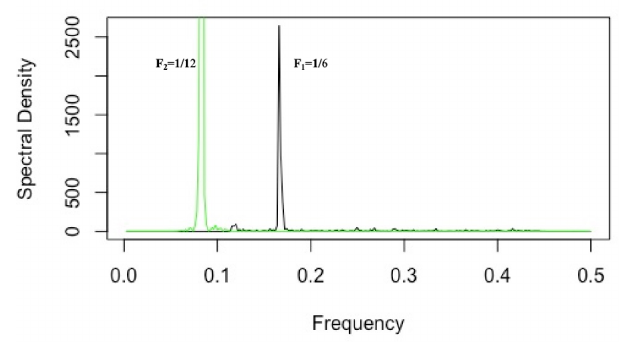
Figure 10. TCO EAWD 1 (black line) and EAWD 2 (green line) spectral contents.